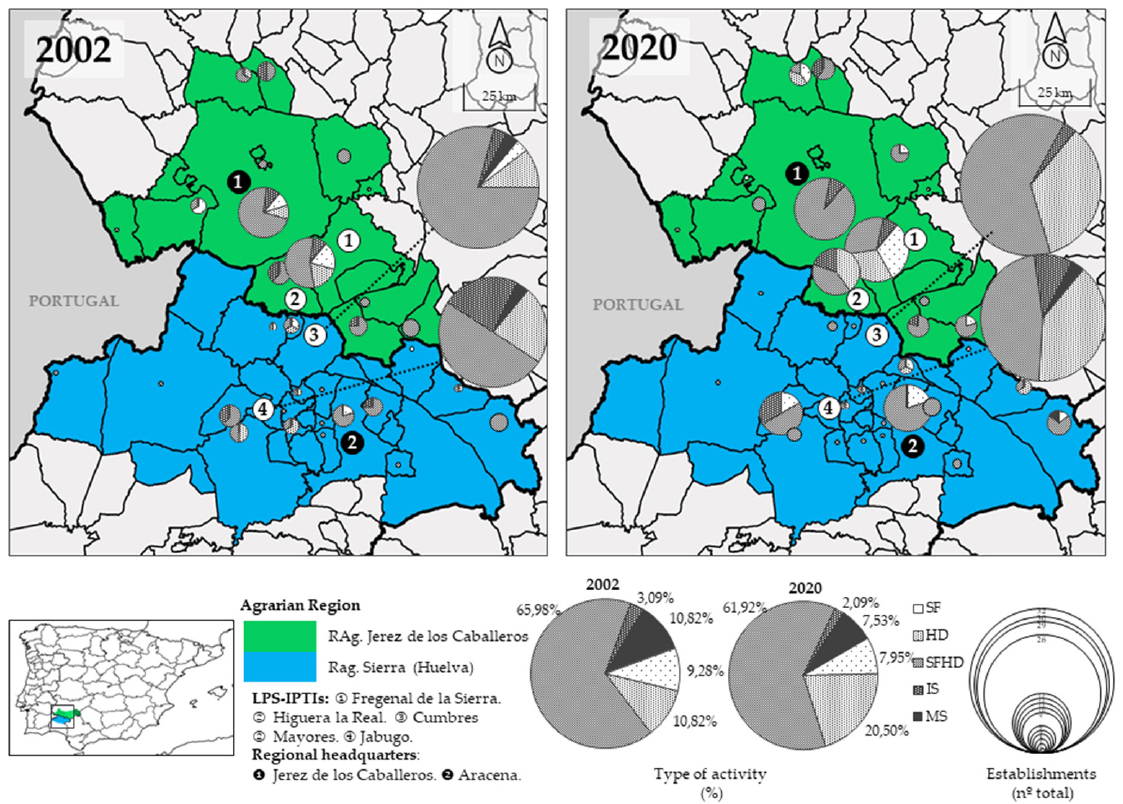
Figure 5. Scope of the study. Agrarian Regions and industries by municipalities (2002 and 2020). Source: [80,94]. Authors own elaboration.